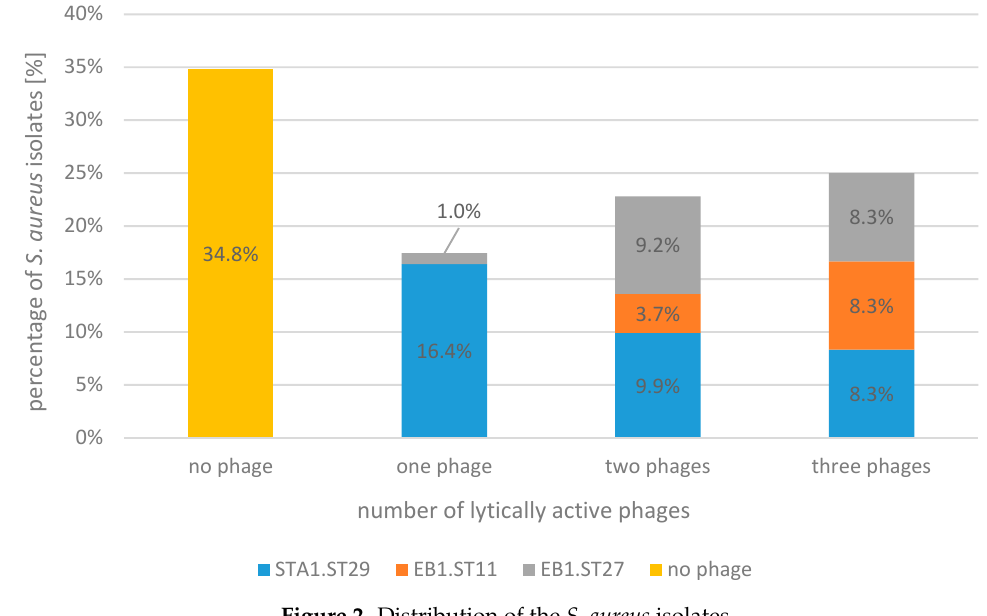
Figure 2. Distribution of the S. aureus isolates.